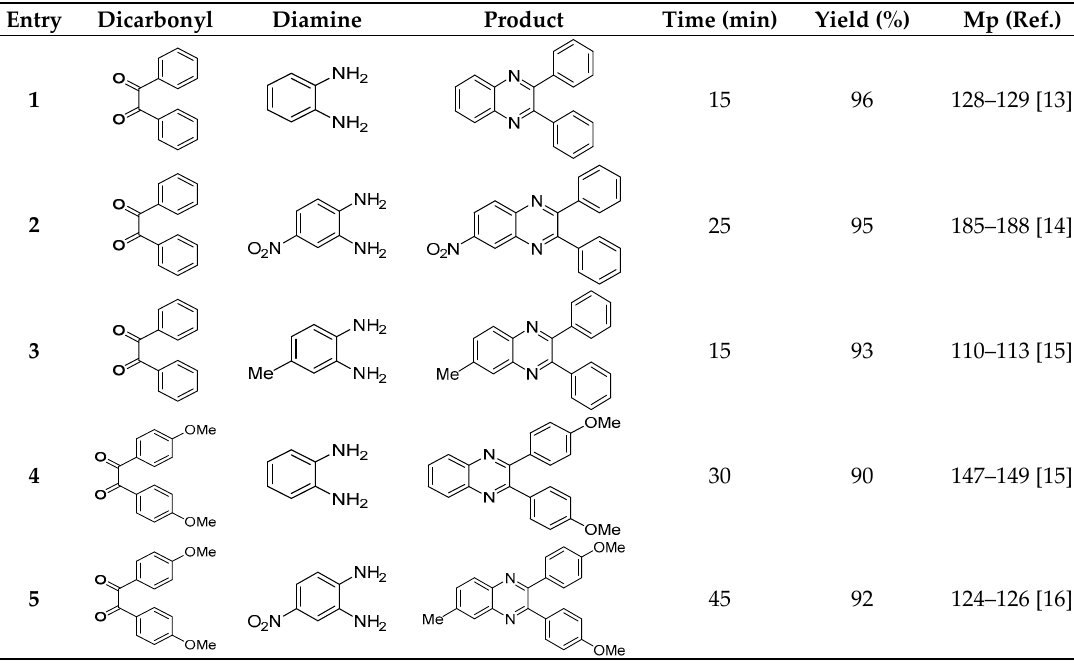
Table 1. Synthesis of quinoxaline derivatives catalyzed by g-C 3 N 4 /Ni under a solvent-free